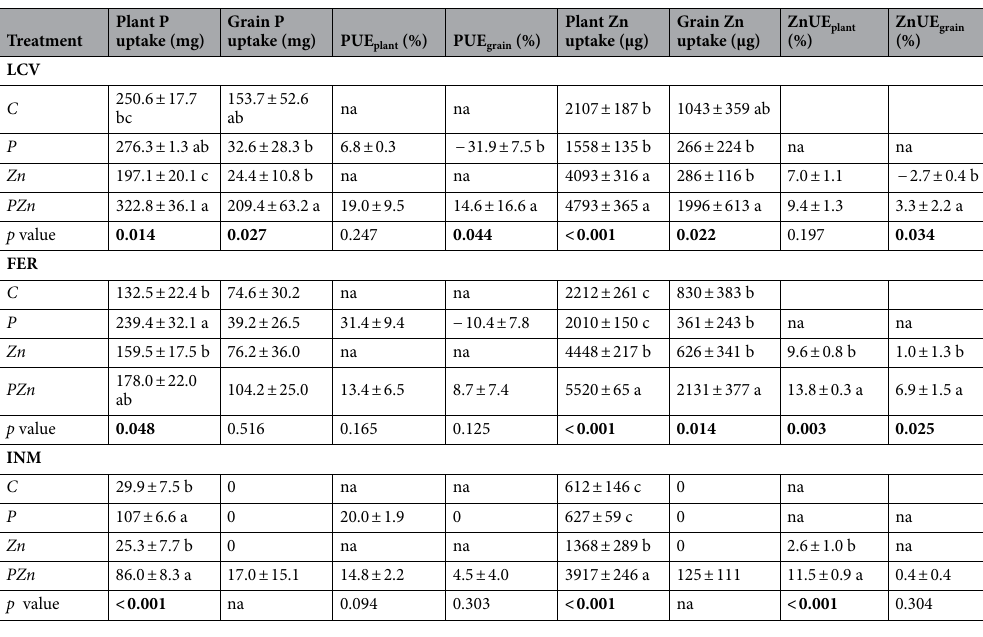
Table 2. Phosphorus and zinc uptake (plant and grain), and phosphorus and zinc use efficiency (plant and grain PUE and ZnUE, respectively) at harvest (mean ± standard error, n = 4) as a function of the treatment for each soil (LCV, FER and INM). Significant p values are in bold to indicate significant differences. p value: probability level of the one-way ANOVA. Different letters indicate significant differences between the treatments, according to the posthoc LSD test. C : control treatment (no P or Zn were added); P : phosphorus fertilization (40 mg P kg −1 ; no Zn was added); Zn : zinc fertilization (3 mg Zn kg −1 ; no P was added); PZn :